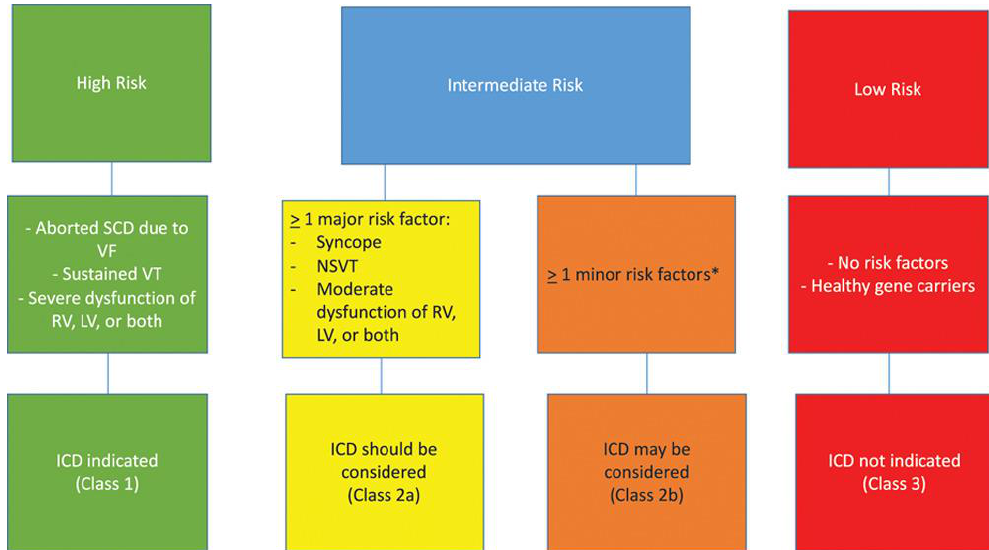
Figure 4. Flow chart of risk stratification and indications of ICD implantation in ACM. Based on the available data on annual mortality rates associated with specific risk factors, the estimated risk of major arrhythmic events in the high-risk category is >10%/year; in the intermediate category, it ranges from 1 to 10%/year; and in the low-risk category, <1%/year. Indications of ICD implantation were determined by consensus considering not only the statistical risk, but also general health, socioeconomic factors, the psychological impact and the adverse effects of the device. * See the text for distinction between major and minor risk factors. ACM = arrhythmogenic cardiomyopathy; ICD = implantable cardioverter defibrillator; LV = left ventricle; NSVT = non sustained ventricular tachycardia; RV = right ventricle; SCD = sudden cardiac death; VF = ventricular fibrillation; VT = ventricular tachycardia. Modified with permission from Corrado et al. [42]. In asymptomatic patients with no risk factors and in healthy gene carriers, there is generally no indication of prophylactic ICD implantation because of the low risk of arrhythmias and the significant risk of device- and electrode-related complications during long-term follow-up